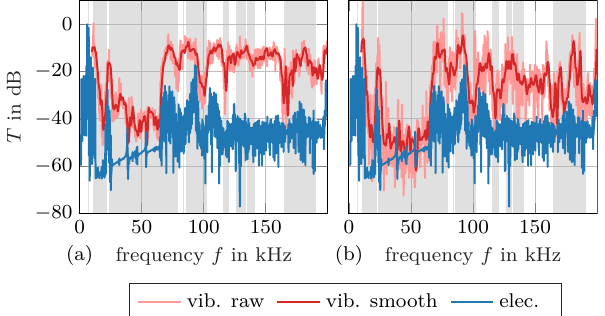
Figure 10. Measured transmission factor for Sample 2: The spatial data of the vibrometer measure- ments have been contracted with ( a ) the quadratic mean (energy transmission) and ( b ) the arithmetic mean (preserving the phase). The calculated band gaps wider than 5kHz are highlighted in